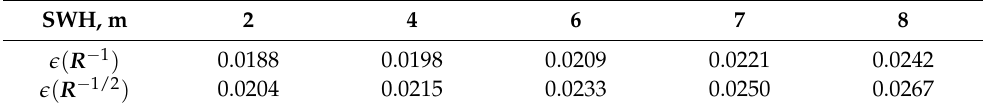
Table 1. Block-diagonal approximation errors for the SWOT precision matrix R − 1 and its symmetric square root for various values of the significant sea surface height. SWH,